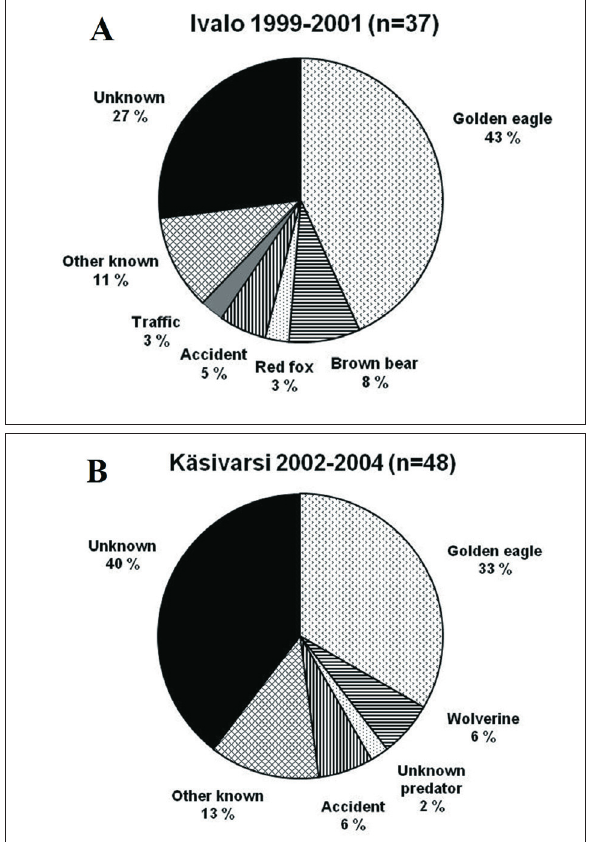
Fig. 3. The distribution of all death causes for radio-collared calves found dead (A) in Ivalo and (B) in Käsivarsi reindeer- herding cooperative during the